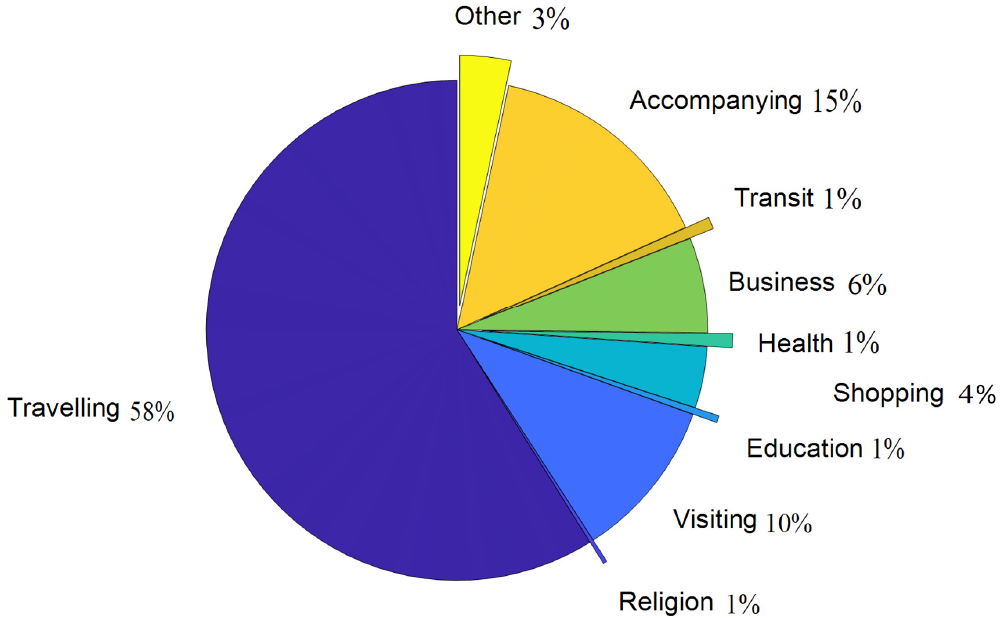
Figure 3. Percentages of the departing foreign visitors by reason.